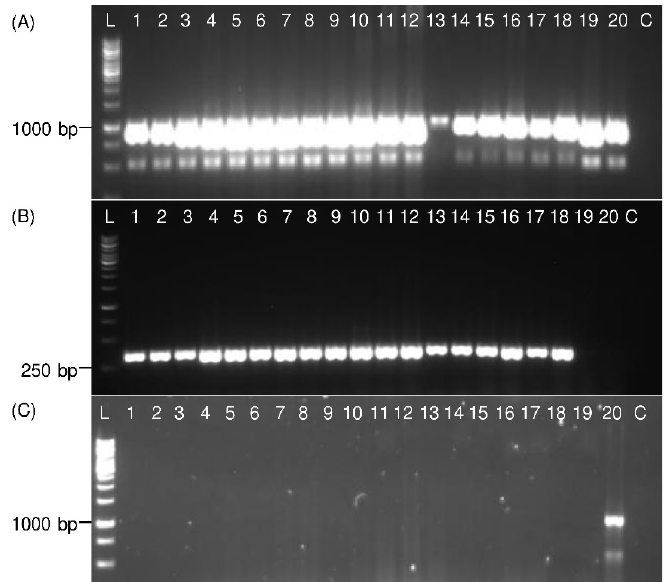
Figure 6. Electrophoretic patterns of PCR products show detection of P. leporinus eggs and nymphs from PBS extracts. In panel ( A ), universal Ron and Calvin primers, in panel ( B ), specific P. leporinus primers and in panel ( C ), universal UEA3 and UEA8 primers were used for PCR. Lanes 1–3 represent single egg samples; 4–6 first instar; 7–9 second instar; 10–12 third instar; 13–15 fourth instar; 16–18 fifth instar; 19 R. quinquecostatus female adult (control); 20 H. obsoletus female adult (control); C: Negative control (water). The sizes of amplicons are shown on the left side and compared with 1 kb ladder (L).